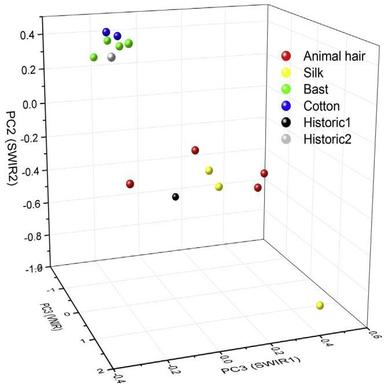
PCA score plots of experimental and historic textile samples (3 selected PCs).